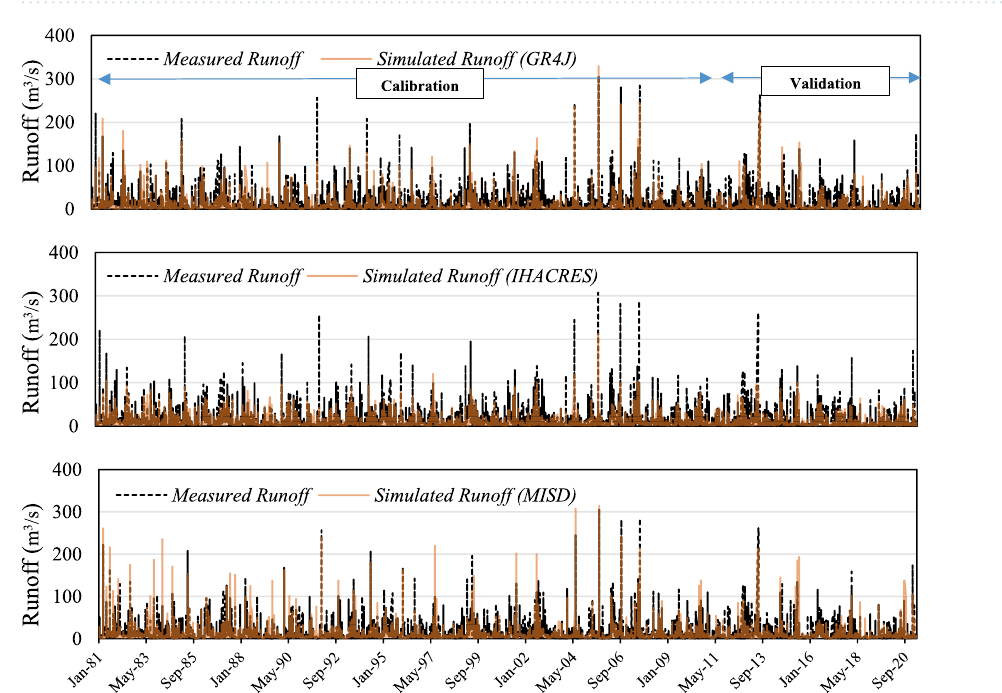
Figure 5. The plot of measured vs simulated runoff time series using GR4J, IHACRES, and MISD